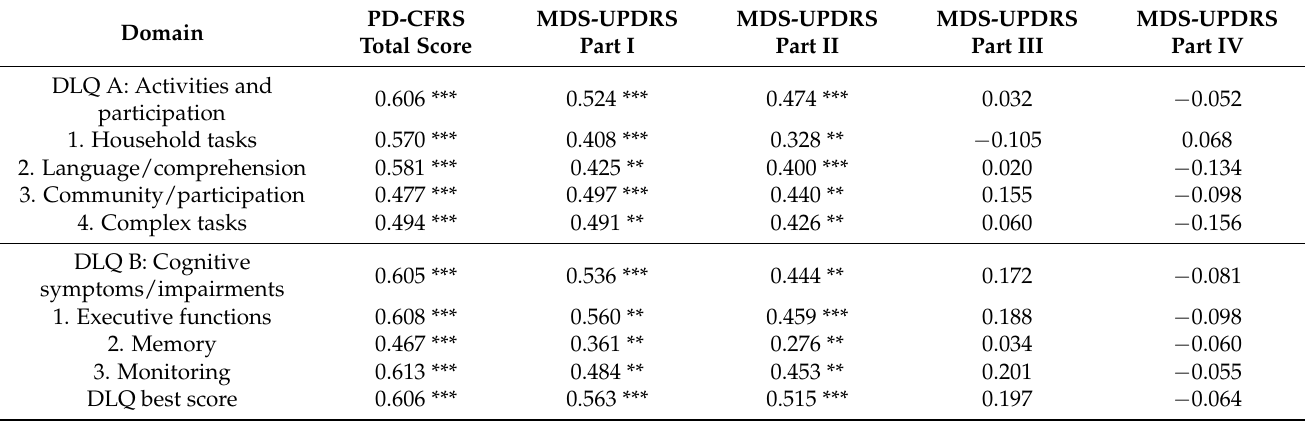
Table 3. Nonparametric correlations between the PD-CFRS total score, the MDS-UPDRS subscales and total scores, and the TOPS and DLQ domains in the sample of Parkinson’s disease patients ( n =